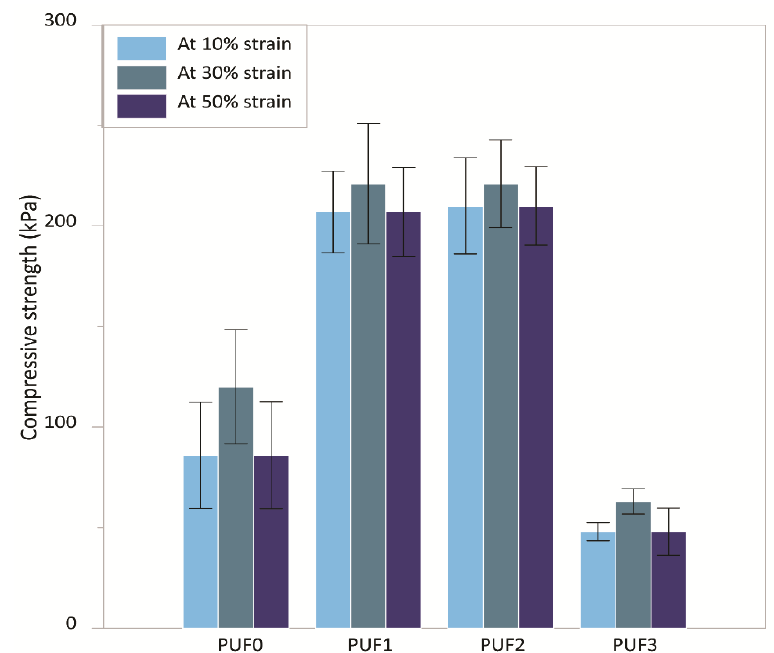
Figure 10. Compressive strength of synthesized polyurethane foams.